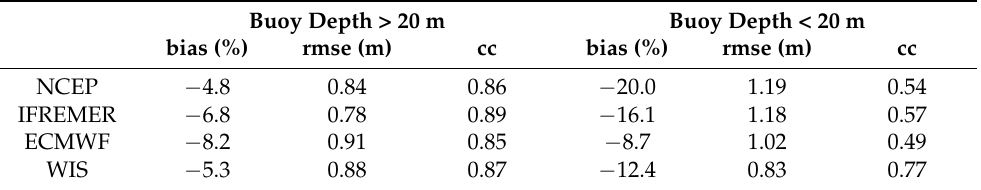
Table 3. Summary of error statistics for deep (>20 m) and shallow (<20m) buoy locations for four hindcast wave models. Statistics were computed from all observed extreme wave events (Hs > 3 m) generated from the six hurricanes. Buoy Depth > 20 m Buoy Depth < 20 m bias (%) rmse (m) cc bias (%) rmse